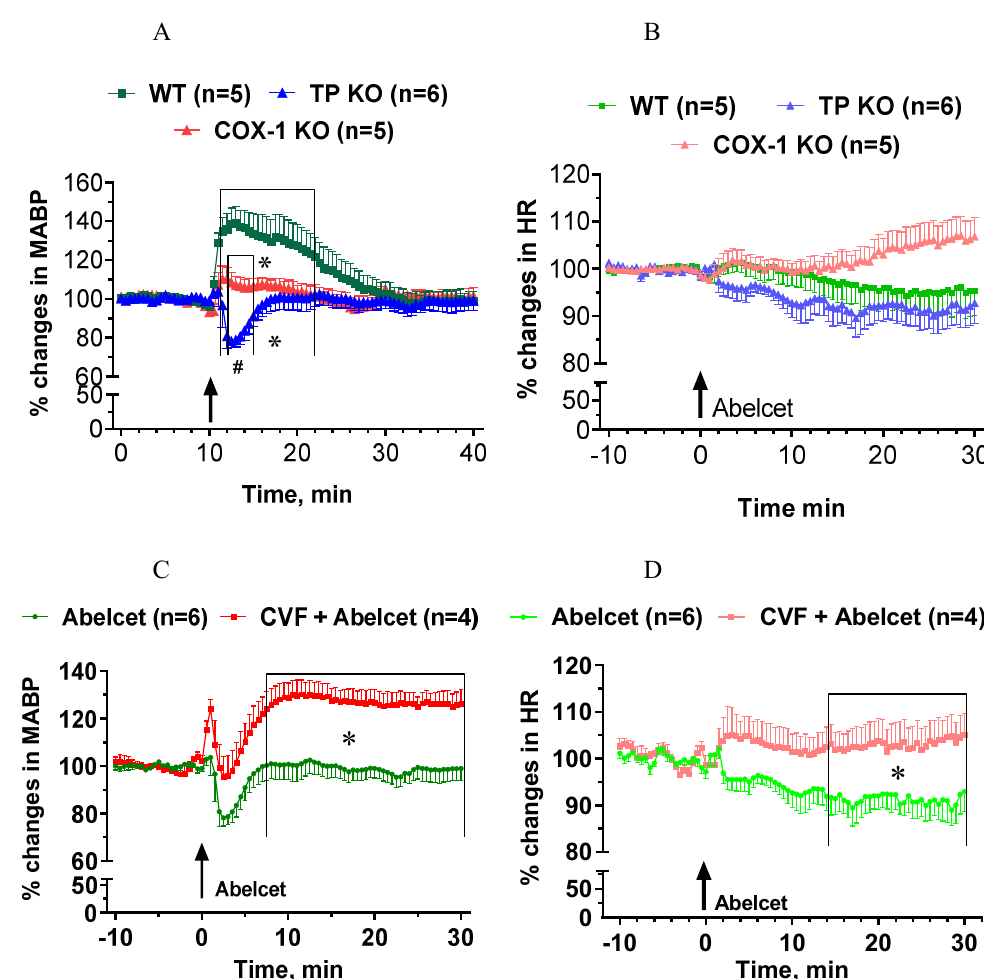
Figure 5. Effects of Abelcet on MABP and HR in anesthetized, control a complement depleted cyclooxygenase-1 (COX-1) or thromboxane prostanoid receptor (TP)-deficient and wild type (WT) C57BL/6N mice. ( A , C ) Effects of Abelcet on mean arterial blood pressure (MABP) and ( B , D ) on heart rate (HR) in COX-1- or TP-deficient and WT C57BL/6N mice. ( A , B ) Effects of Abelcet on MABP and HR in complement depleted TP-deficient and WT C57BL/6N mice. Complement depletion was accomplished with pretreatment with cobra venom factor (CVF). * p < 0.05 vs. wild type (WT) mice; # p < 0.05 between TP- and COX-1-deficient mice. WT and TP- or COX-1-deficient or control and complement depleted groups were compared using two-way ANOVA for repeated measurements followed by Dunnet’s multiple comparison tests. The effects of Abelcet on mean arterial blood pressure (MABP) was almost fully abolished in COX-1-deficient mice but heart rate (HR) was not affected. The Abelcet-induced hypertension was reverted to a transient hypotension in TP-deficient mice but heart rate (HR) was not affected. Depletion of complement with CVF caused a delayed hypertension in TP-deficient mice from 8 min, and HR was also significantly increased from 14 min after Abelcet administration.